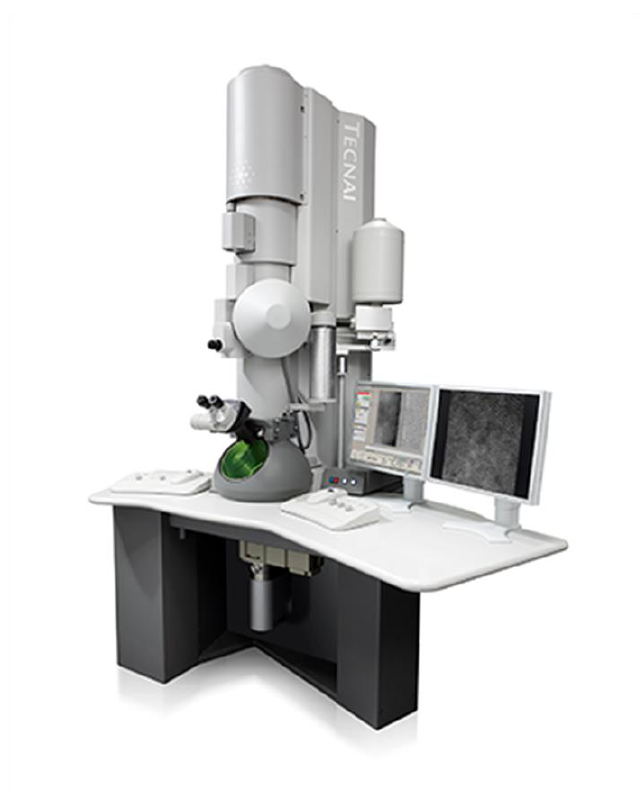
Figure 1: FEI Tecnai G2 F20 transmission electron microscope (photograph by courtesy of FEI